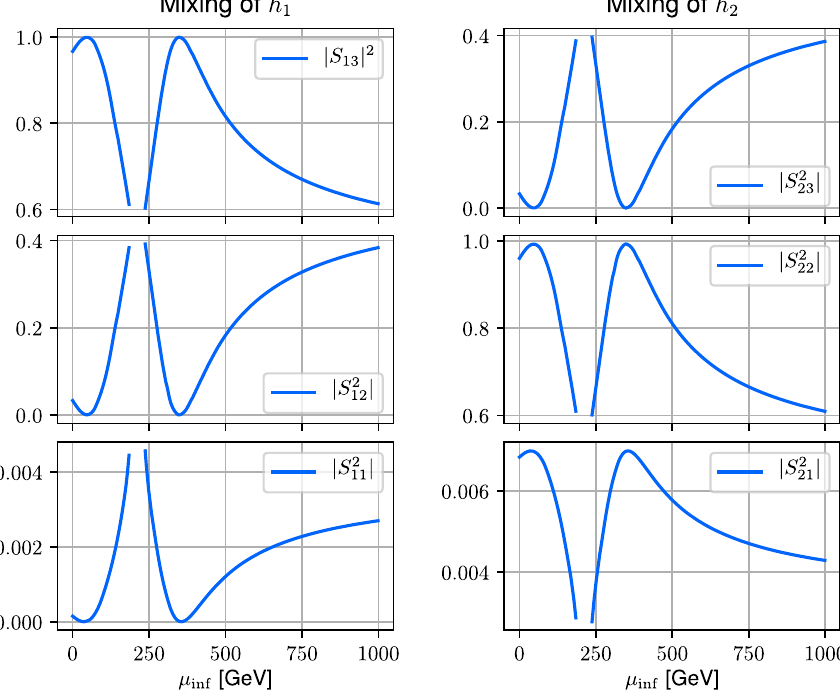
, ˜ χ 0 , and chargino ˜ χ ± , depending on μ inf 1 1 2